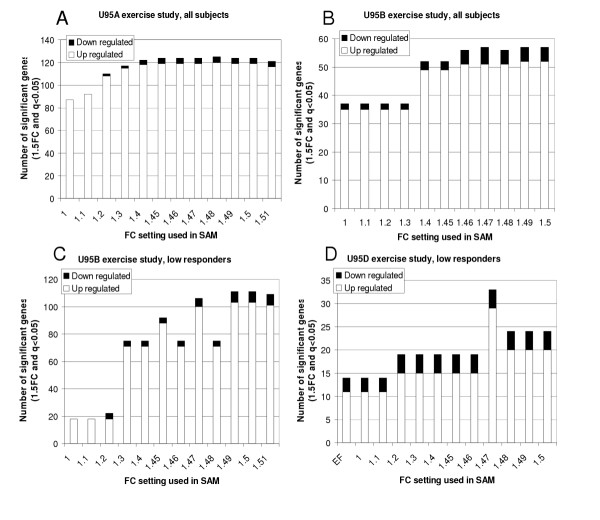
FC effects on the endurance training data set: SAM analysis was used at various fold changes studying the exercise data set while scoring genes with a q-value of <0.05 and FC>1.5. This was done to asses the effect of the fold change option in the SAM Excel addin on genes reported as significant at a higher fold change. The figure shows the number of scored genes using 4 different chip and sample combinations: (A) All eight subjects before and after training (totally 16 arrays) were compared in a paired analysis using the U95A chips. (B) All eight subjects before and after training (totally 16 arrays) were compared in a paired analysis using the U95B chips. (C) The reduced group consisting of low four low responders (totally 8 arrays) were compared in a paired analysis using the U95B chips. (D) The reduced group consisting of low four low responders (totally 8 arrays) were compared in a paired analysis using the U95D chips.